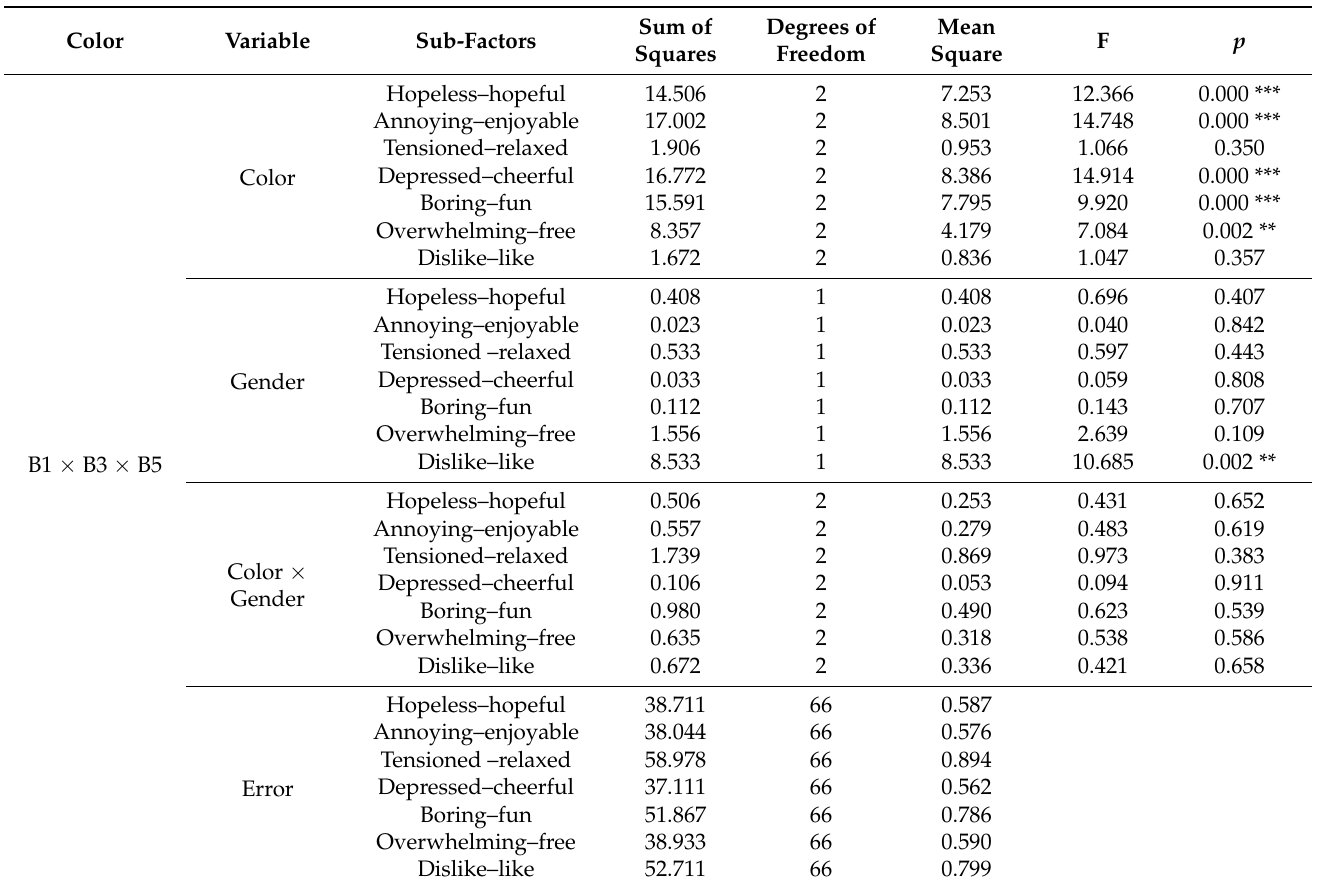
Table 12. Main and interaction effects of stress according to chroma changes under blue hue and low-value